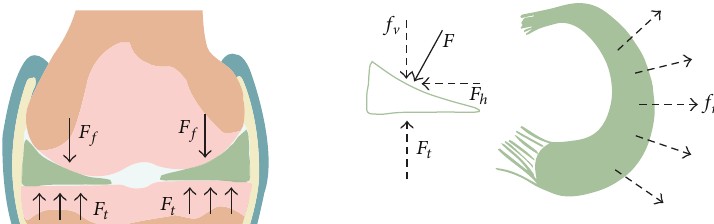
Figure 3: Schematic diagram of themeniscus force-bearing mechanism. Meniscal configuration adapts well tothe corresponding shapeof the femoral condyles and the tibial plateau in the knee joint. The axial load force ( 𝐹 ) perpendicular to the meniscus surface and horizontal force ( 𝑓 𝑟 ) are created by compressing the femur ( 𝐹 𝑓 ). 𝐹 rebounds due to the tibial upgrade force ( 𝐹 𝑡 ), whereas the 𝑓 𝑟 leads to meniscal extrusion radially, which is countered by the pulling force from the anterior and posterior insertional ligaments. Consequently, tensile hoop stress is created along the circumferential directions during axial